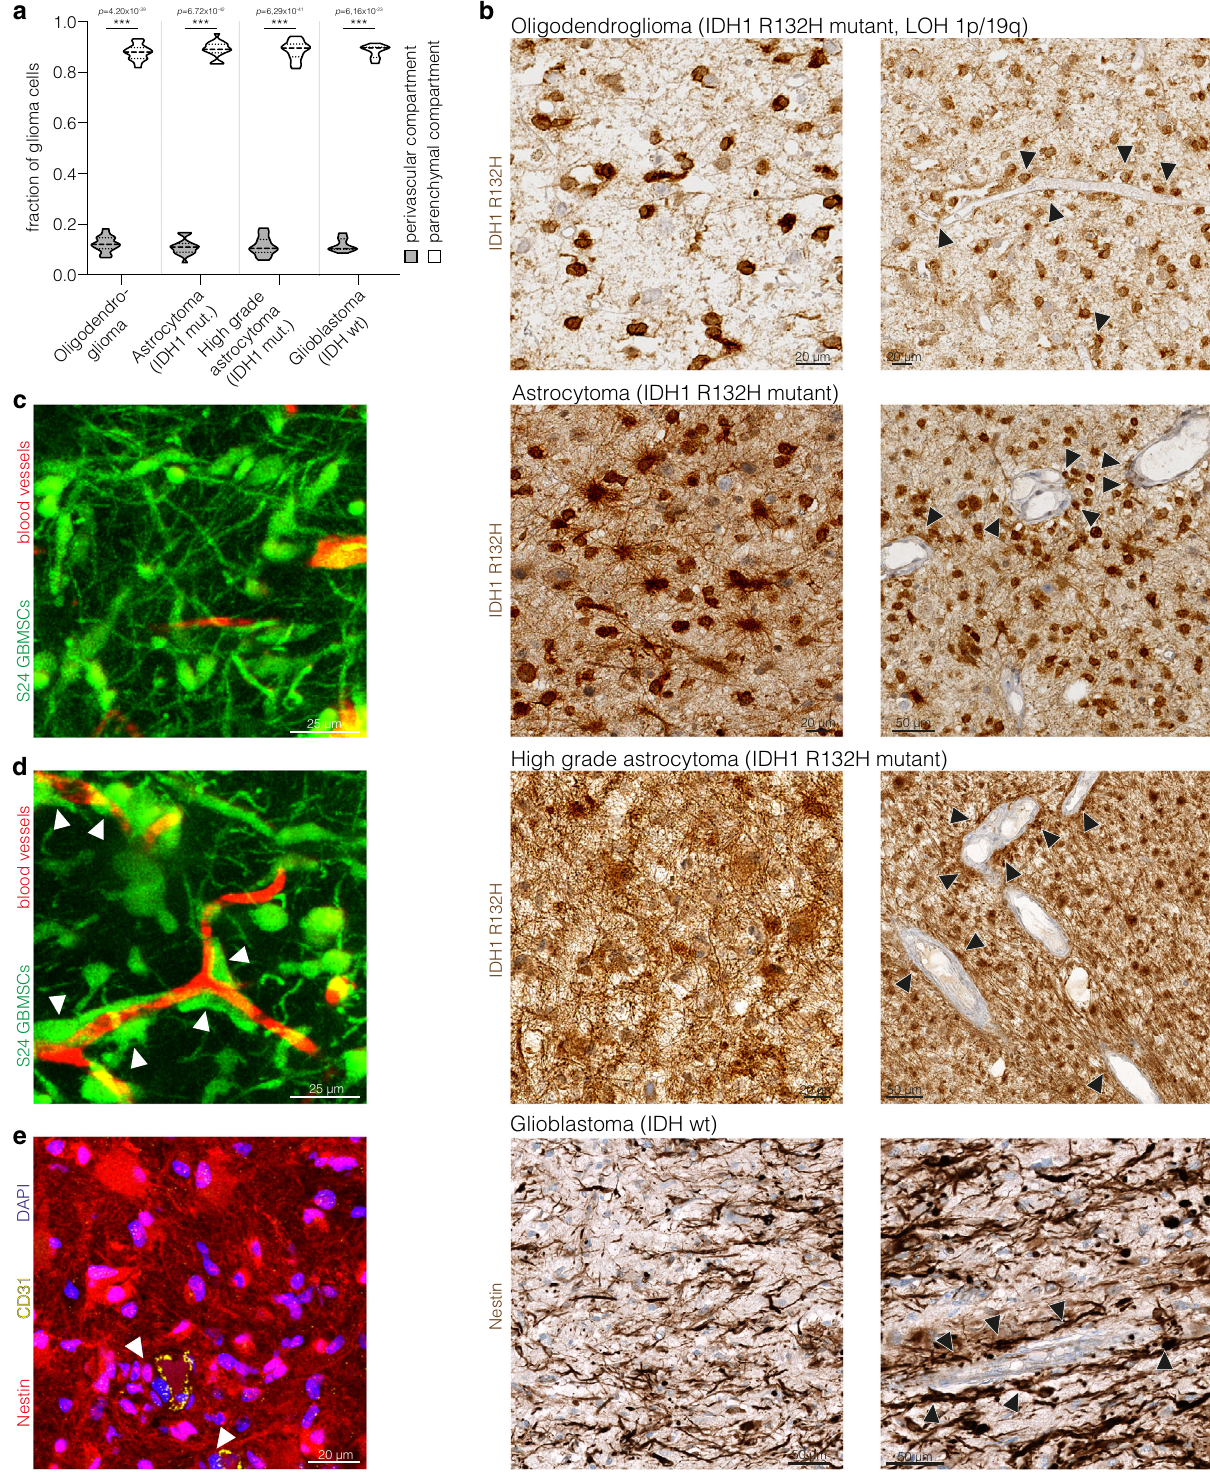
glioblastoma cells, both at the invasive front and in the established tumor core, and are characterized by a quiescent